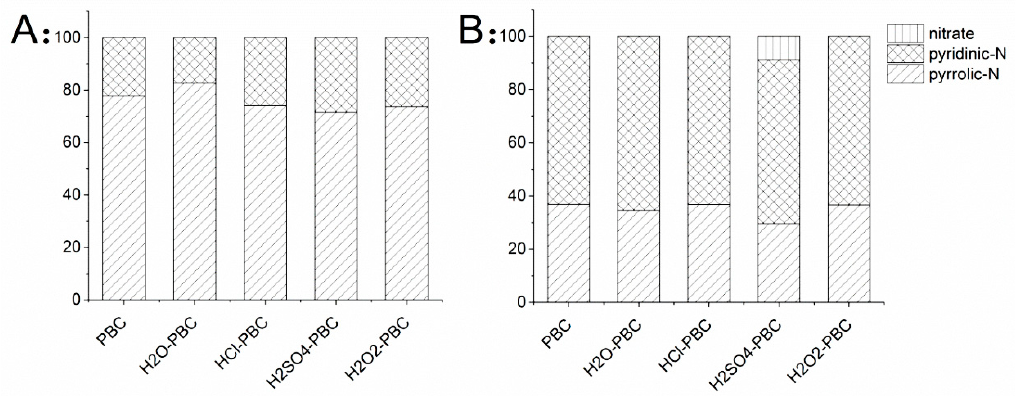
Figure 5. The ratio of N-functional groups on the biochar before and after NH 4+ -N adsorption (A: before adsorption and B: after adsorption).